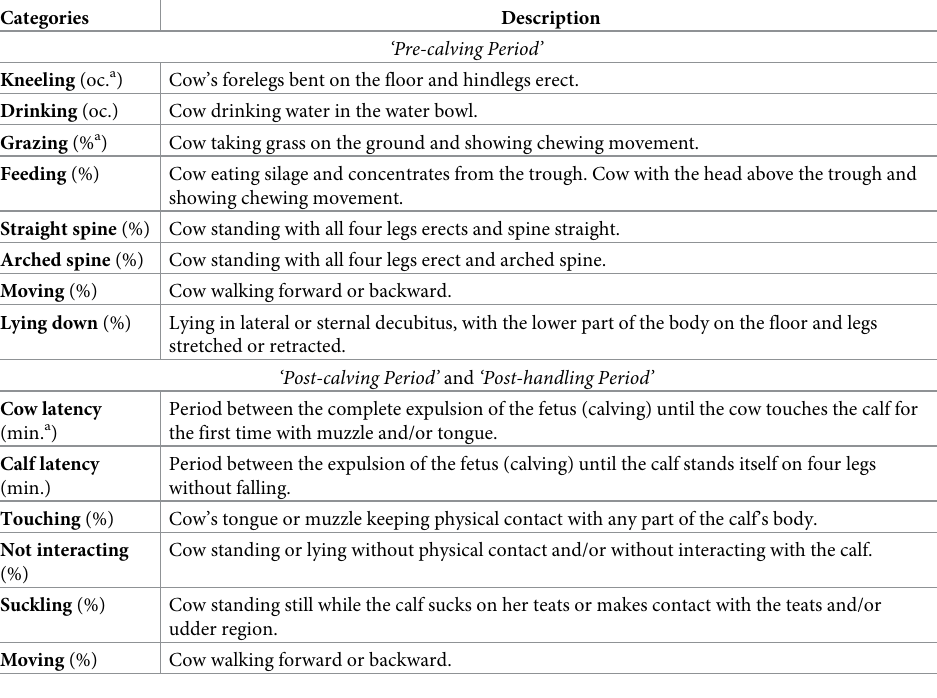
Table 1. Ethogram of Gyr cows behaviors and their calves in the peripartum period.